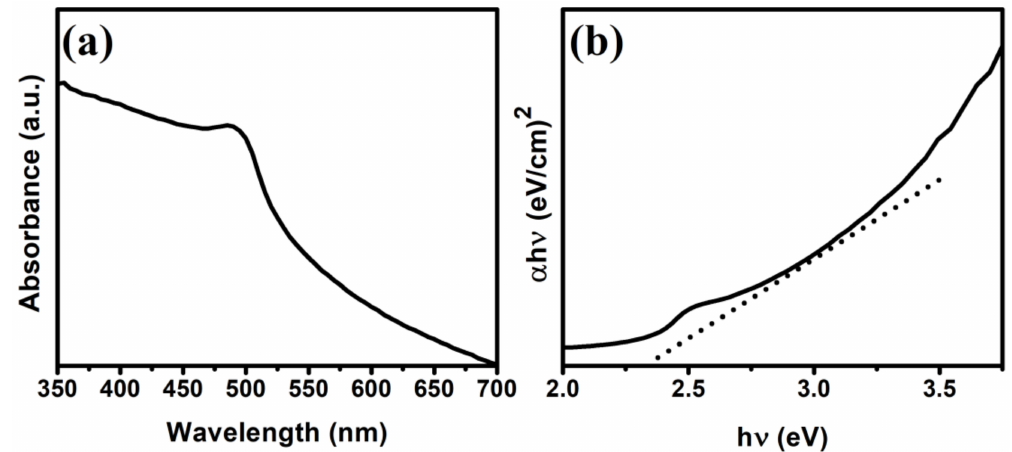
Figure 3. UV-vis DRS ( a ) and estimated bandgap energy ( b ) of CdS NRs.